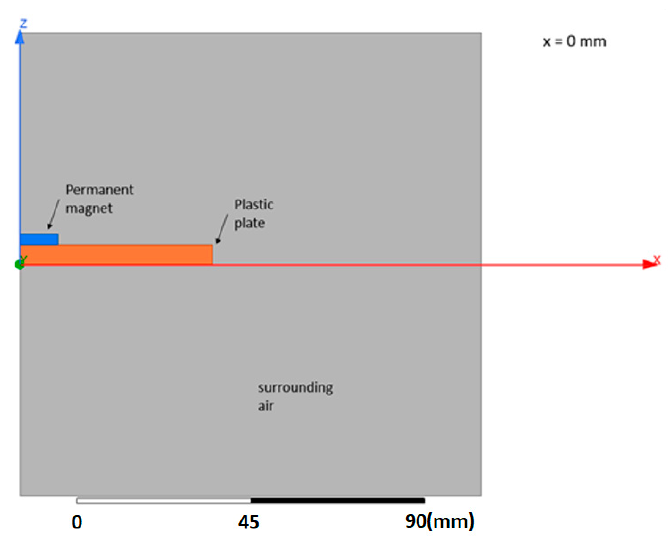
Figure 8. The FEM model of the permanent magnet and plastic plate with a magnetic filler.